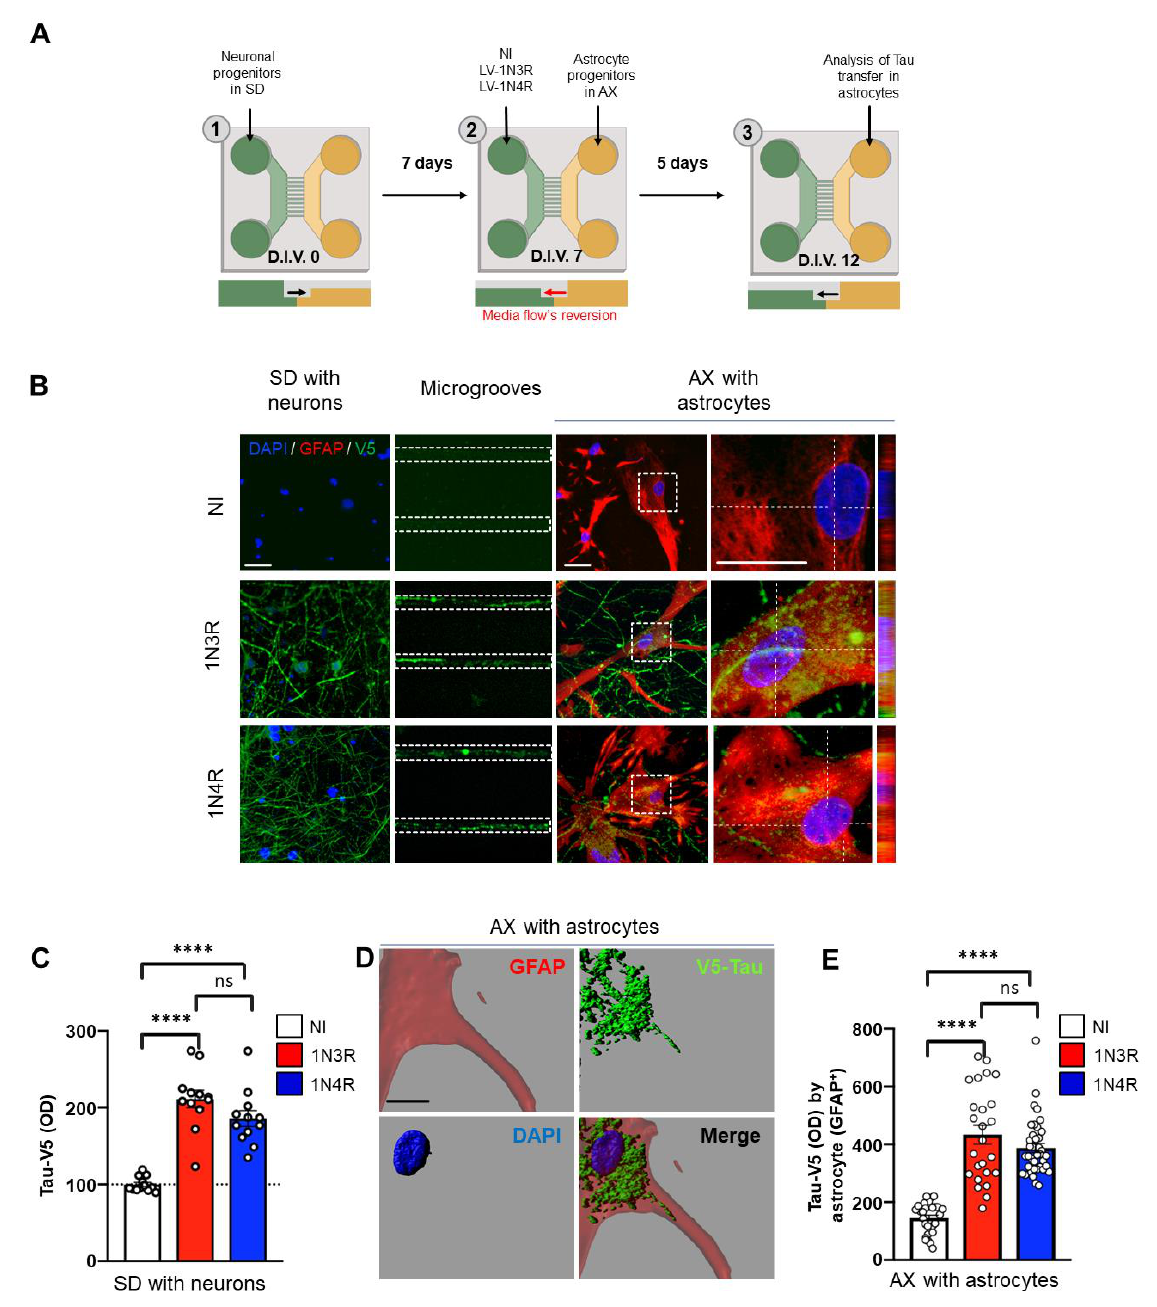
Figure 1. Tau is shuttled from neurons to astrocytes. ( A ) Schematic of the microfluidic system used to investigate tau transfer from hippocampal neurons to astrocytes. ( B ) Confocal micrographs showing 1N3R or 1N4R tau (V5+) and astrocytes (GFAP+) in the somatodendritic and axonal compartments and microgrooves. ( C ) Histogram showing the Tau-V5 optical density in the so- matodendritic compartment. ( D ) 3D reconstruction of confocal micrographs showing tau (V5+) in an astrocyte (GFAP+) in the axonal compartment. ( E ) Histogram showing the number of Tau-V5 inclusions detected per astrocyte. The scale bars are 20 µ m ( B ) and 5 µ m ( D ). SD = somatoden- dritic compartment, AX = axonal compartment, LV = lentiviral vector, NI = noninfected. For ( C , E ), N = cultures/microfluidic chambers/cells: NI: 1/3/32, 1N3R: 1/3/25, 1N4R: 4/3/39. Ordinary one-way ANOVA with Sidak’s multiple comparison test. ( ns p >0.05, **** p <